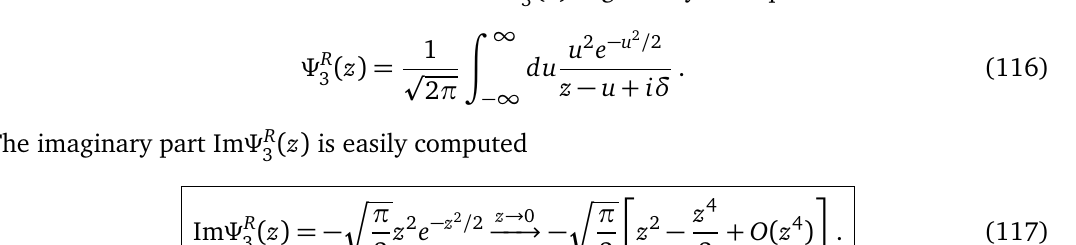
Figure 11: Left: Re [ Ψ R (red curve), Im [ σ R